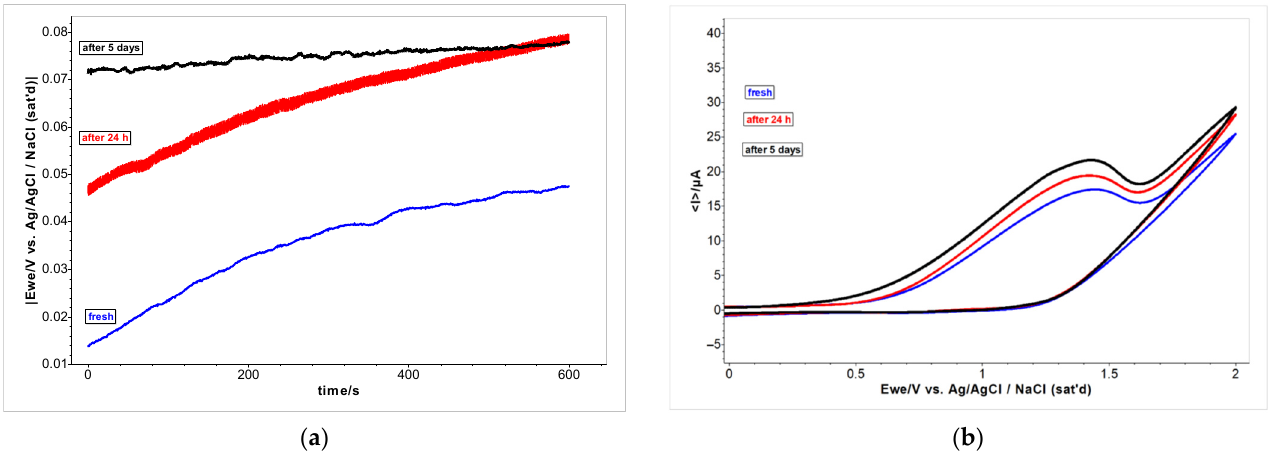
Figure 6. ( a ) The evolution of the potential (E) by OCV registered for 10 min of A. foeniculum AdB EO with time; ( b ) Cyclic voltammograms of A. foeniculum AdB EO registered at 24 h and 5 d (E = ± 2 V/Ag/Ag Cl sat , at 100 mVs − 1 ).